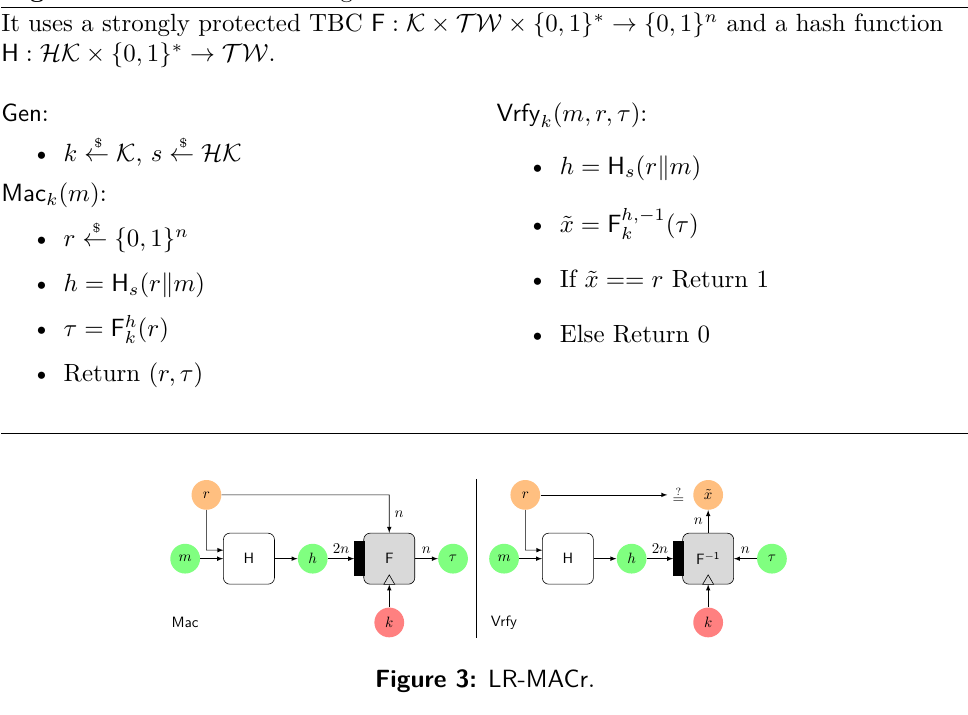
Algorithm 3 The LR-MACr algorithm.